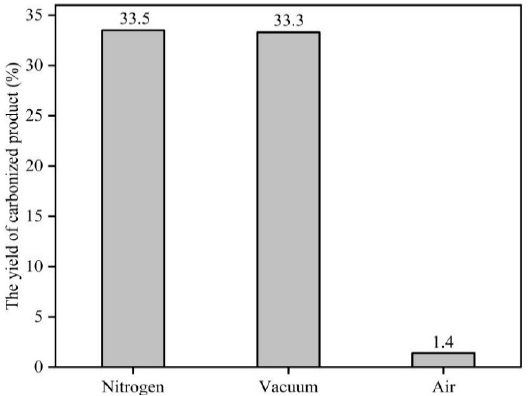
Figure 5. The yield of carbonized product under three different pyrolysis atmospheres.